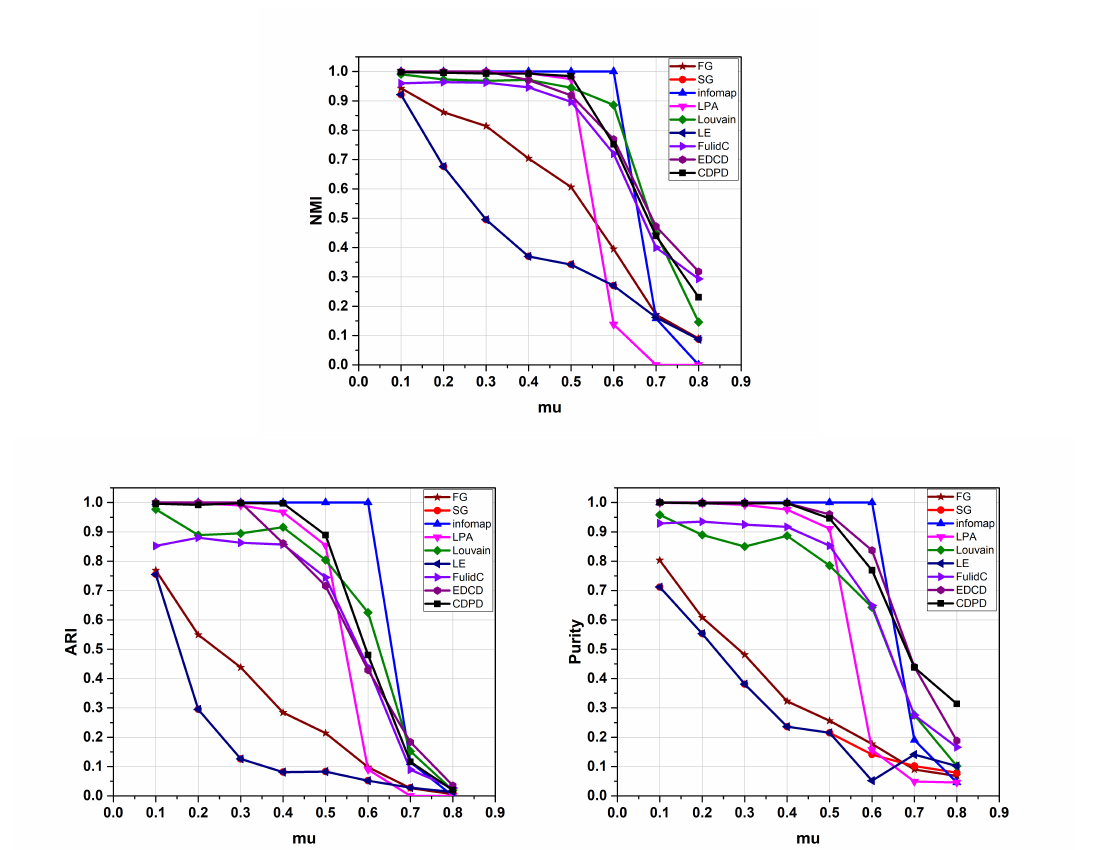
Figure 2. Performances of the above algorithms on the synthetic networks generated by LFR by varying the mixing parameter from mu 0.1 to